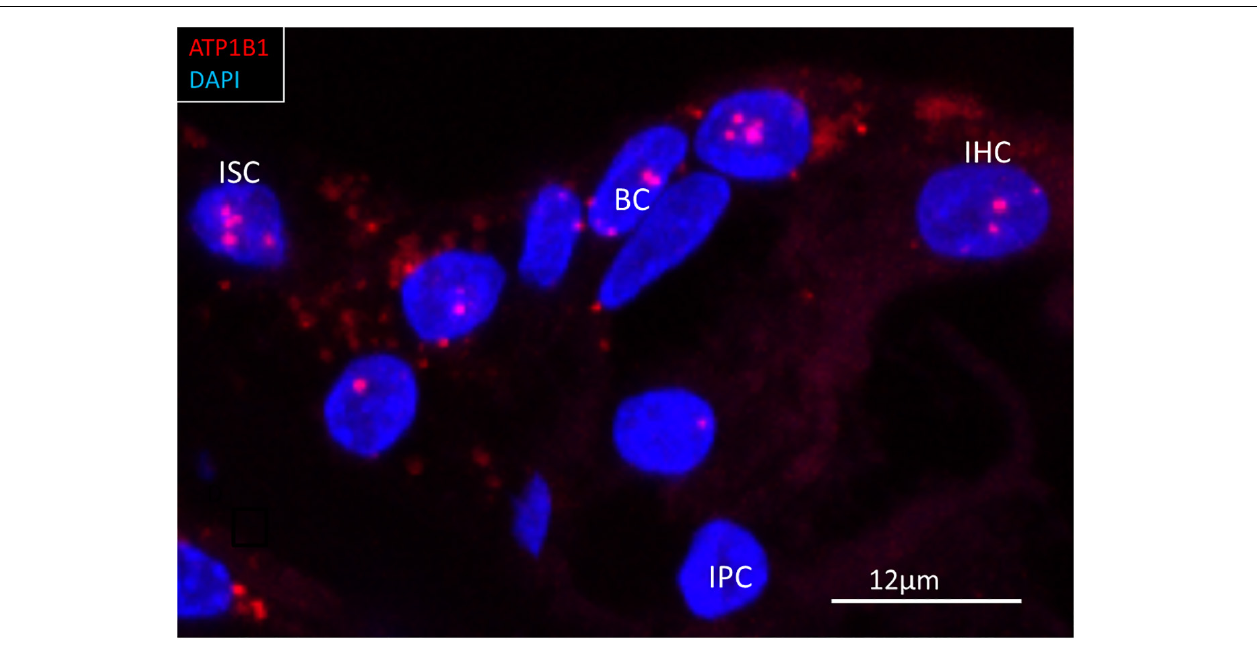
FIGURE 9 | RNAscope R (cid:13) of ATP1B1 transcripts in the region of a human inner hair cell (IHC). Gene transcripts are seen in the supporting cells around the IHC. One IHC contained a few transcripts. ISC, inner sulcus cell; IPC, inner pillar cell; BC, border cell.